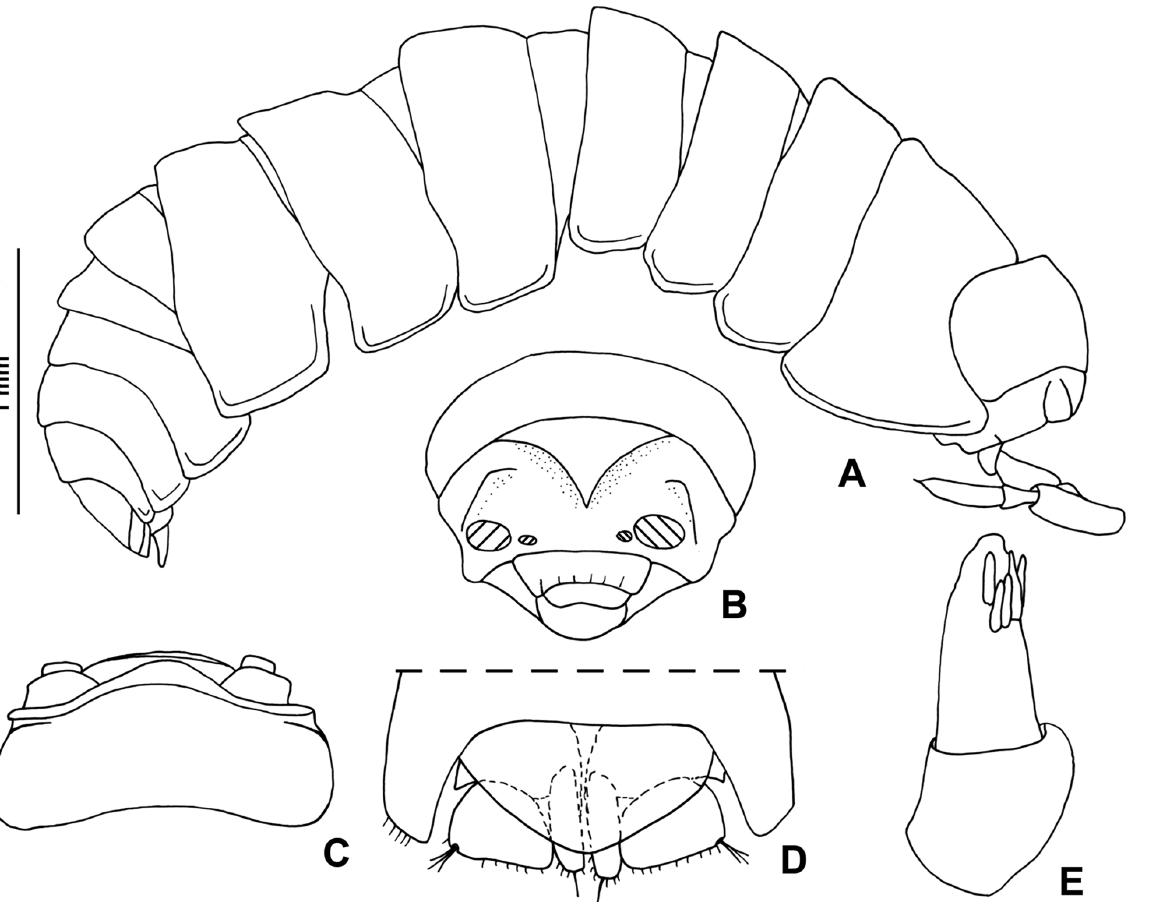
Fig. 32. Paraschizidium sp. from Algar do Javali, Montejunto, ♀. A . Specimen in lateral view. B . Cephalon in frontal view. C . Cephalon in dorsal view. D . Pleonite 5, telson and uropods. E .